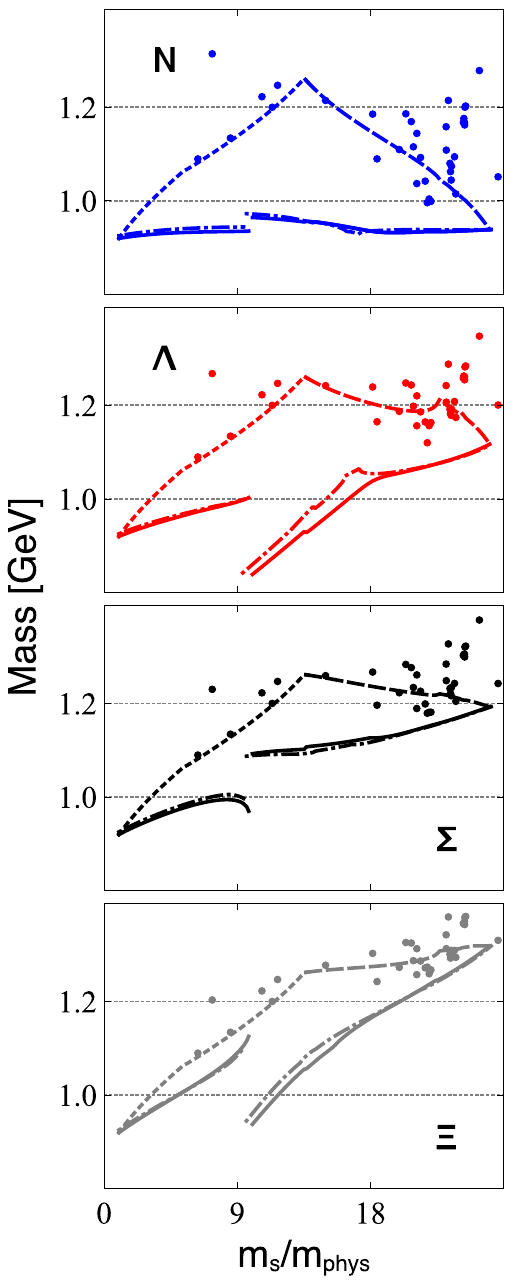
Fig. 2 Baryon octet masses as a function of the strange quark mass at m = m phys from Fit 1 (solid) and Fit 2 (dot-dashed), and m = m s (dotted), m + m s = ( m + m s ) phys (dashed) both from Fit 1. The colored dots correspond to those of Fig. 1 showing our results of Fit 1 on the various lattice